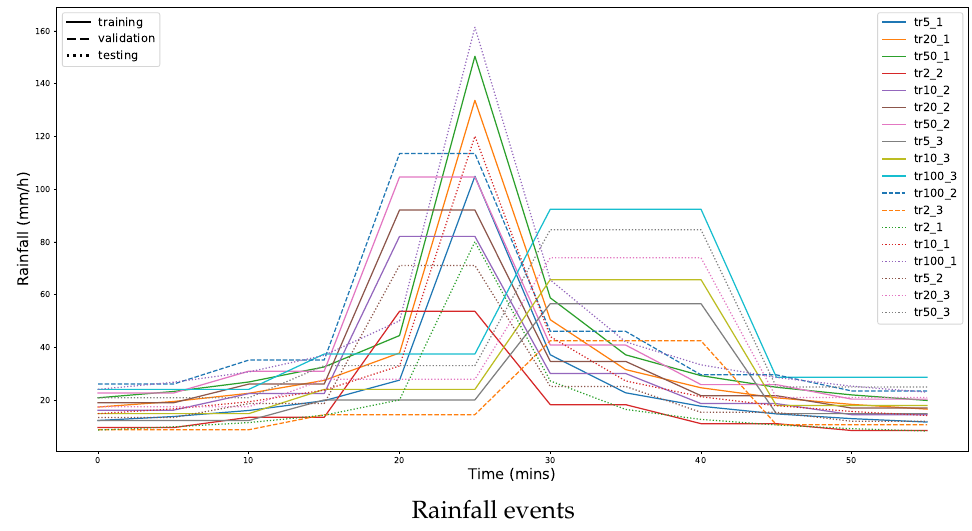
Figure 3. The illustration of our hyetographs used for simulations. The first rainfall number corre- sponds to the return period, while the second to the different events within the same return period in the legend shown in the upper right side of the figure. The different line types, as shown in the upper left legend, refer to the allocation of rainfall events for training, validation, and testing set as described in Table